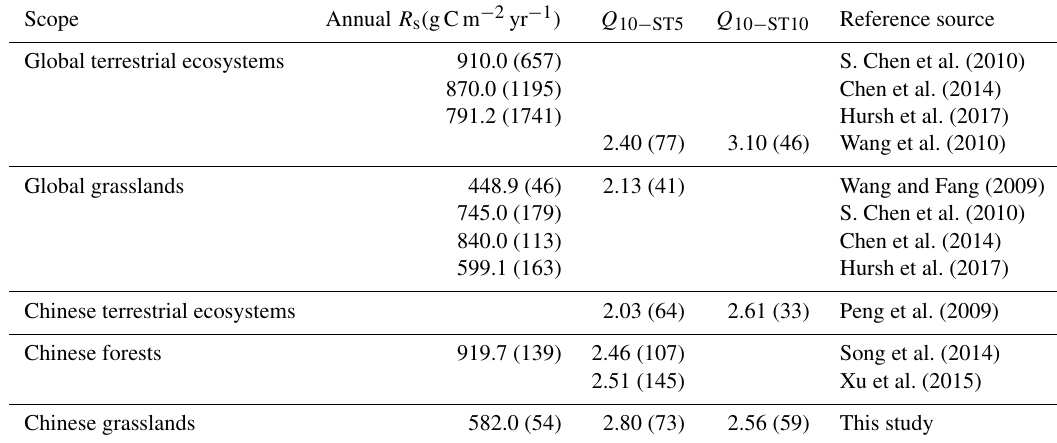
Table 2. Comparisons of annual soil respiration and Q 10 between Chinese grasslands and other syntheses. The numbers in parentheses represent the number of